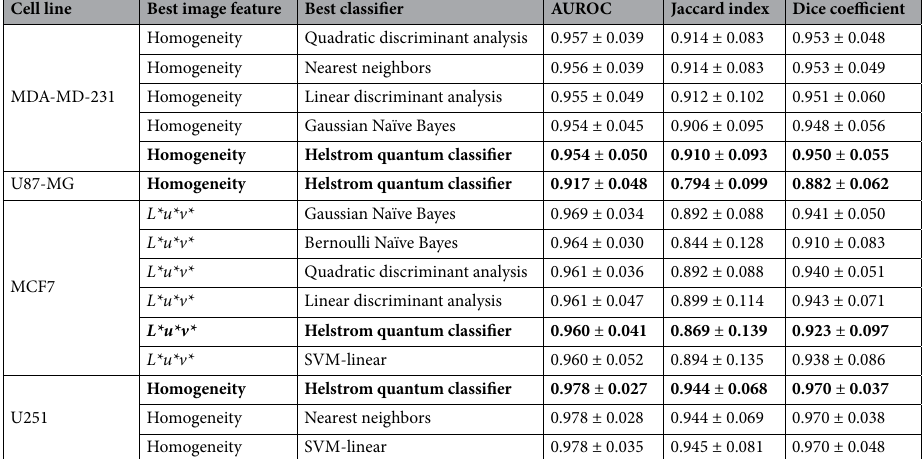
Table 2. The mean and standard deviation AUROC score (with respect to 30 datasets) for the best performing image feature and classifiers (up to and including HQC and classifiers whose score are tied with HQC), with corresponding mean and standard deviation Jaccard index and Dice coefficient, for cell lines MDA-MD-231, U87-MG, MCF7 and U251. The rows in boldface denote the results achieved by the HQC.